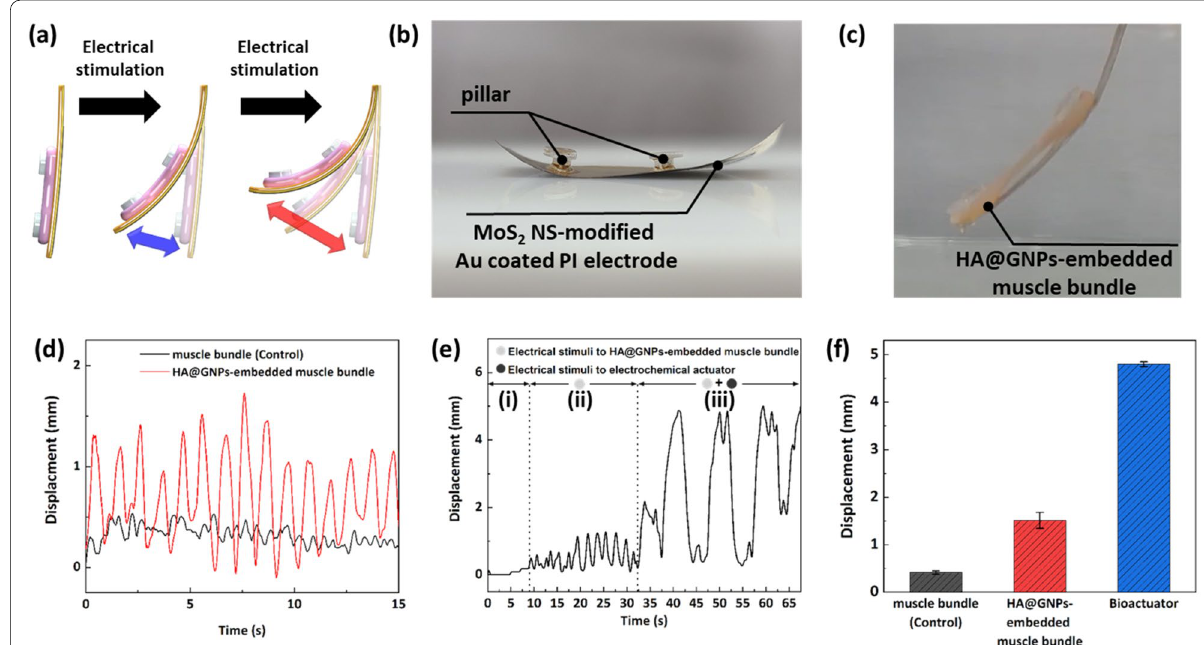
Fig. 4 Verification of electroactive nano‑biohybrid actuator motion performance. a schematic diagram of motion performance of electroactive nano‑biohybrid actuator. Optical images of b MoS 2 NS‑modified Au‑coated PI electrode with pillar and c electroactive nano‑biohybrid actuator. d displacement of HA@GNPs‑embedded muscle bundle and without HA@GNPs (control). e displacement of electroactive nano‑biohybrid actuator (i) without stimulation, (ii) only electrical stimulation, (iii) both electrical and electrochemical stilmulation. f displacement of electroactive nano‑biohybrid actuator compared with HA@GNPs‑embedded muscle